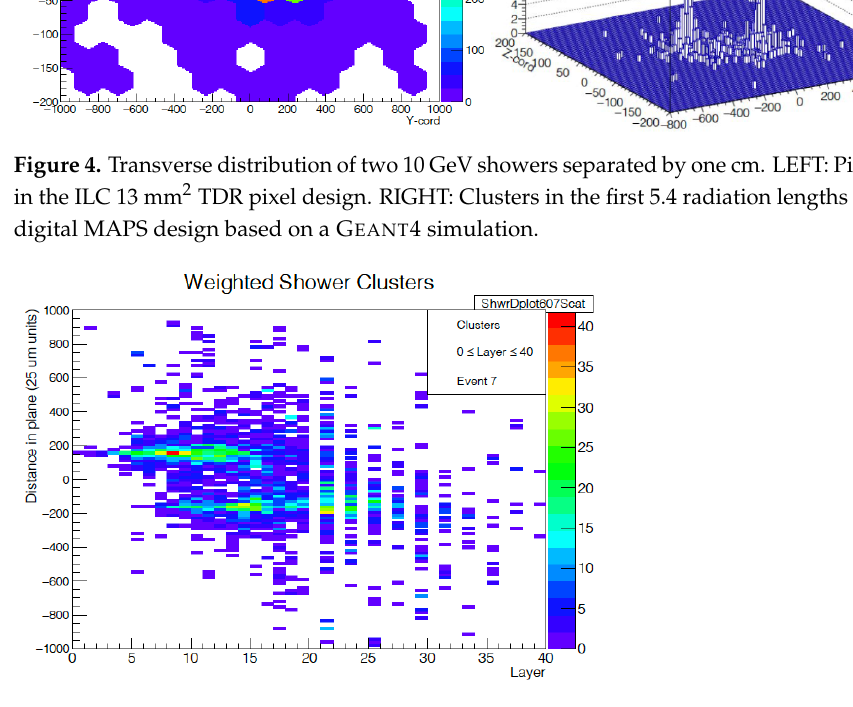
Figure 5. Projection in z-layer plane of the pixel clusters in two 20 GeV gamma showers emerging from a 40 GeV π 0 decay. The z-direction is the 100- µ m pixel direction and the layers shown are 20 thin (0.64 X 0 ) followed by 10 thick tungsten layers. Each vertical bin is 400 µ m wide. The two showers are separated by less than one